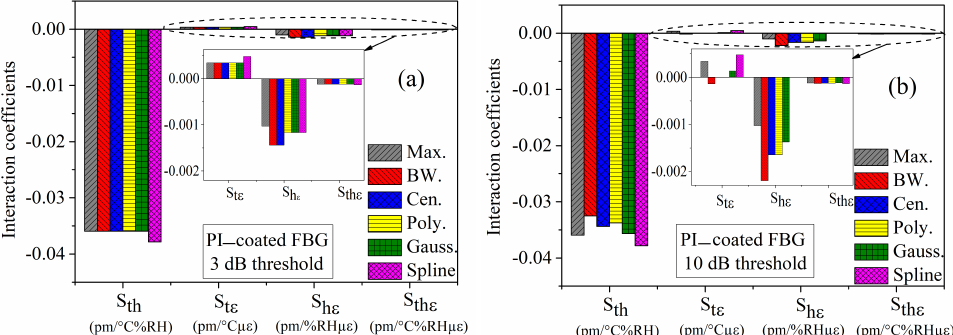
Figure 10. Comparison of interaction coefficients of temperature, humidity, and strain, calculated by different peak tracking methods for PI-coated FBG for thresholds of ( a ) 1 and ( b )